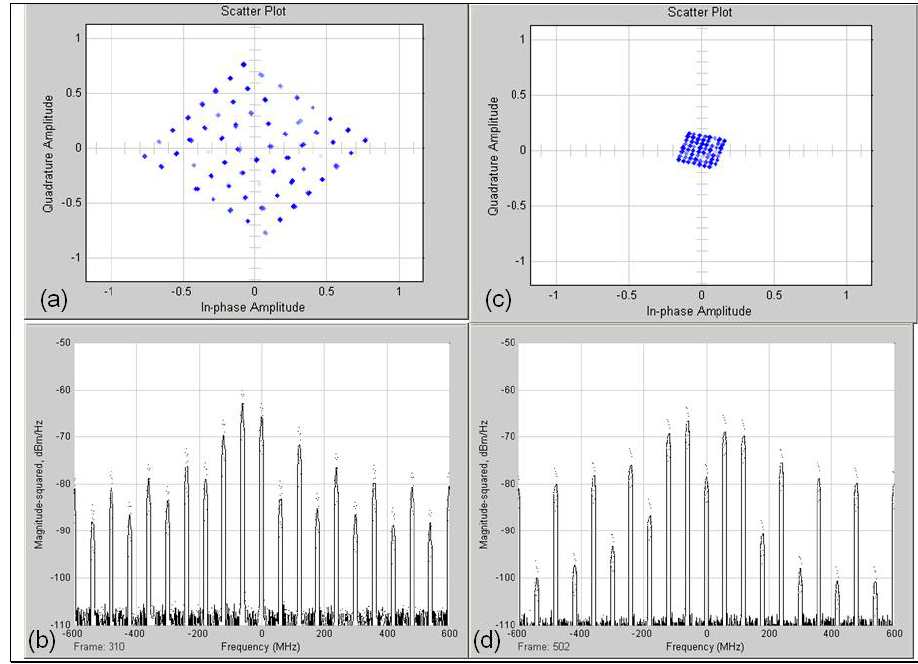
Figure 11. Received constellations and spectra of OAM modes transmitted separately and 0 Hz down-conversion: ( a ) constellation of OAM 8, ( b ) spectrum of OAM8, ( c ) constellation of OAM1, ( d ) spectrum of OAM1.